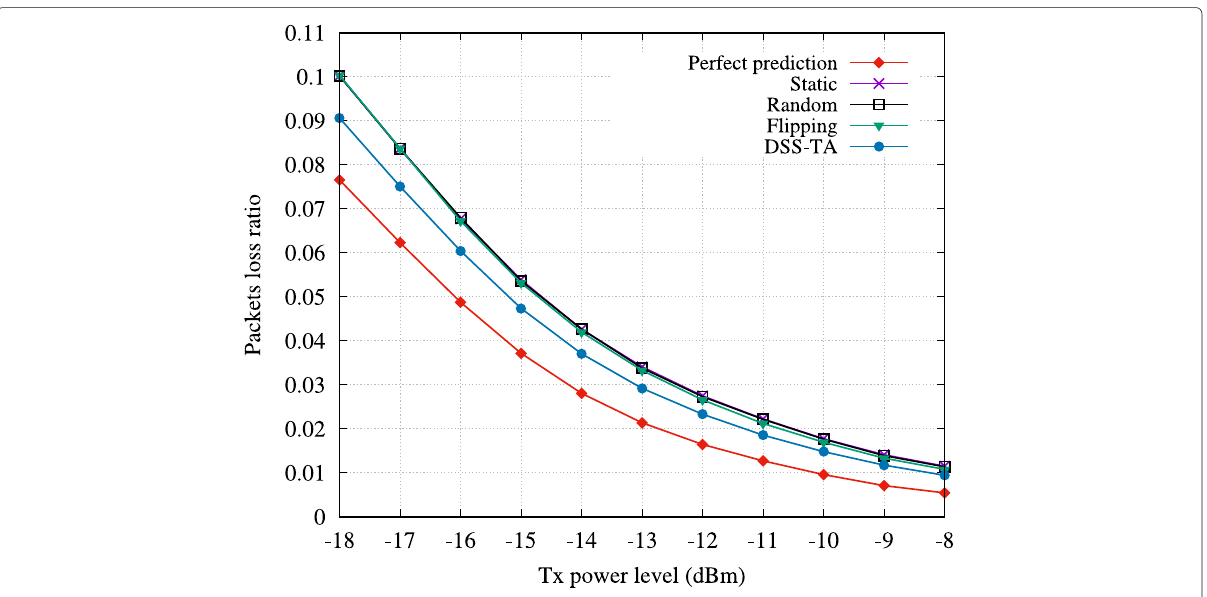
Fig. 12 PLR vs. Tx power lever: superframe length 70 ms, CD 1